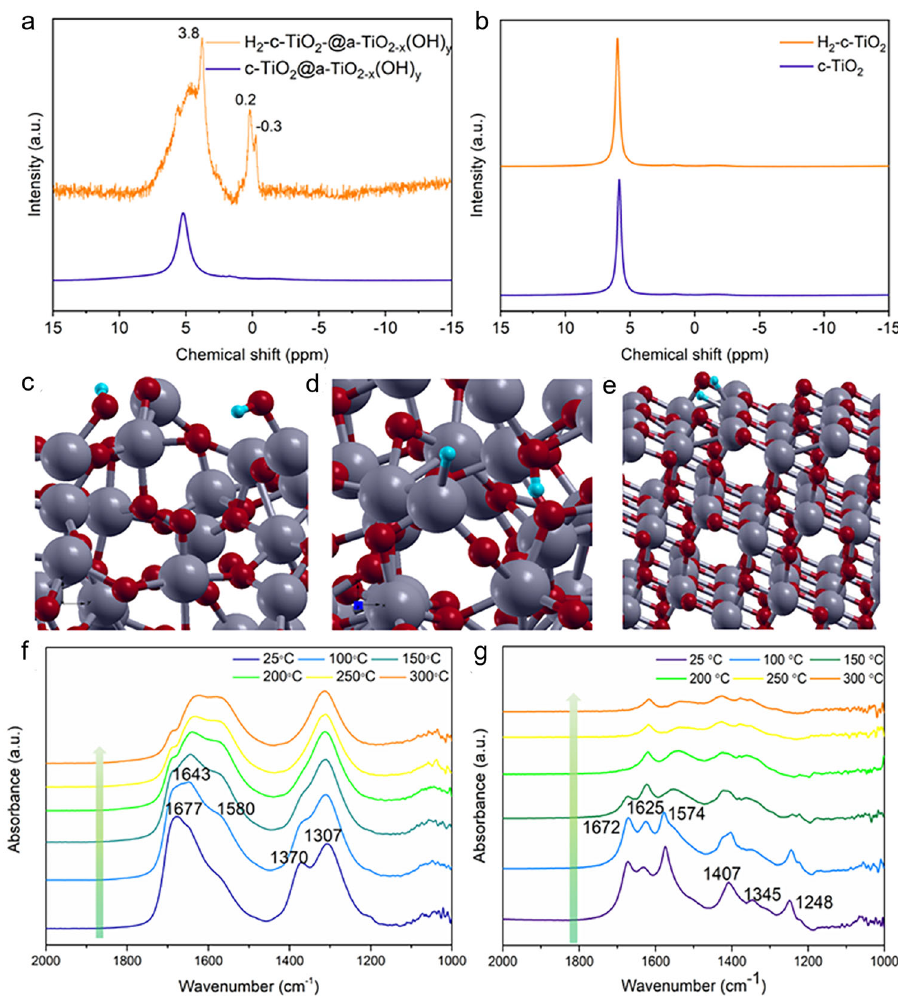
Fig. 5 | Activation of CO 2 by SFLPs on c-TiO 2 @a-TiO 2-x (OH) y . a , b Ex situ solid- state 1 H MAS-NMR spectra of c-TiO 2 @a-TiO 2-x (OH) y (a) and c-TiO 2 ( b ) before (purple) and after (orange) exposure to H 2 at atmospheric pressure and room temperature. c – e H 2 adsorptionresulting intheformationof twosurfaceOH( c )or a Ti-H and an OH on amorphous titania surfaces ( d ), or absorbed H atoms on